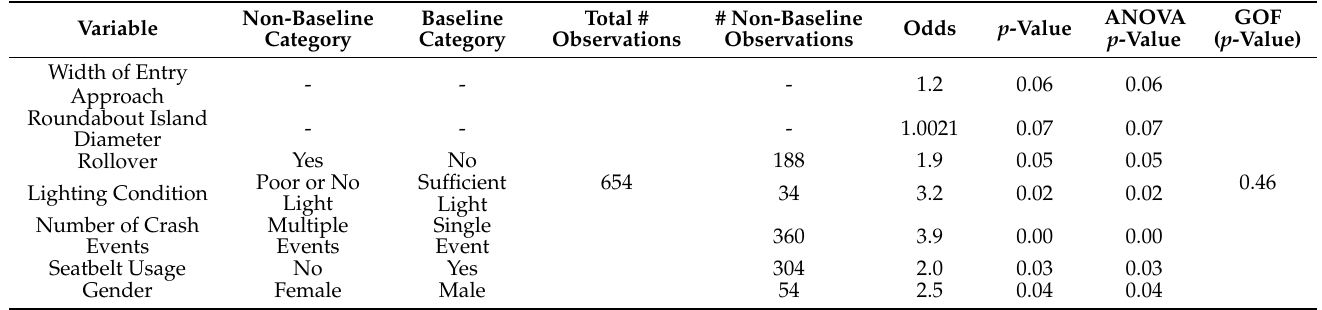
Table 7. Multivariate Roundabout